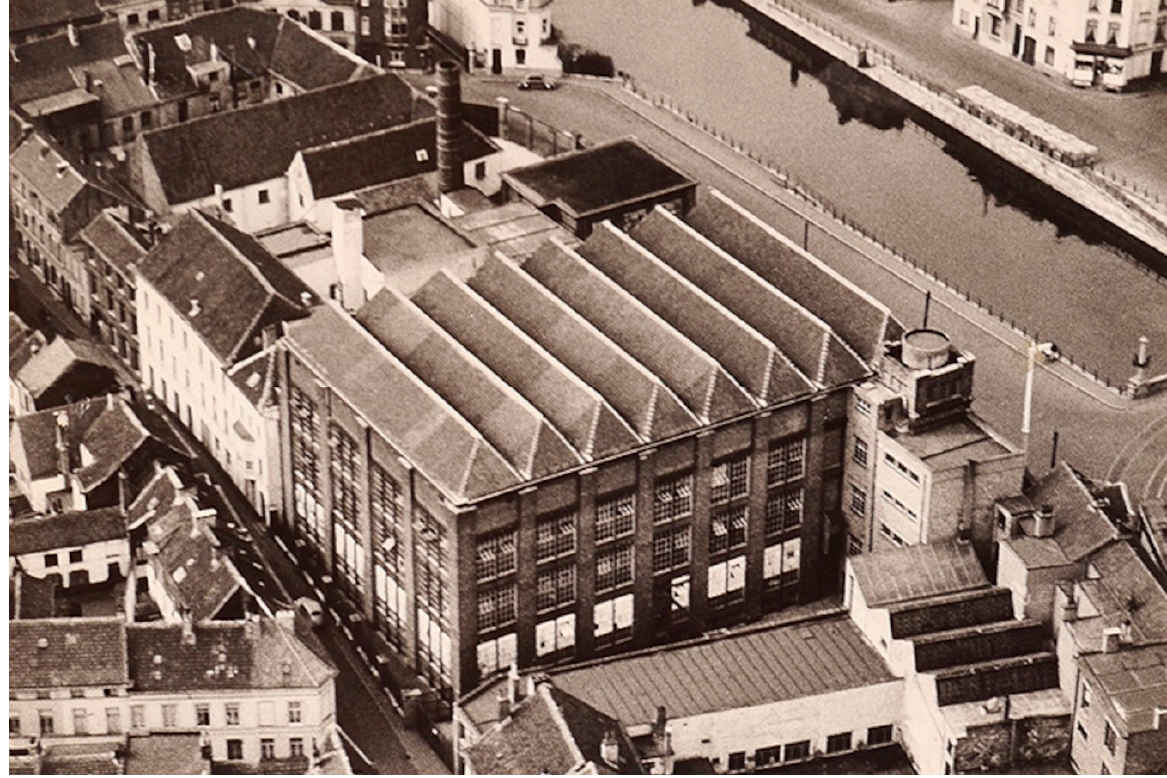
Figure 8. Aerial view of UCO Desmet-Guequier, 1948.